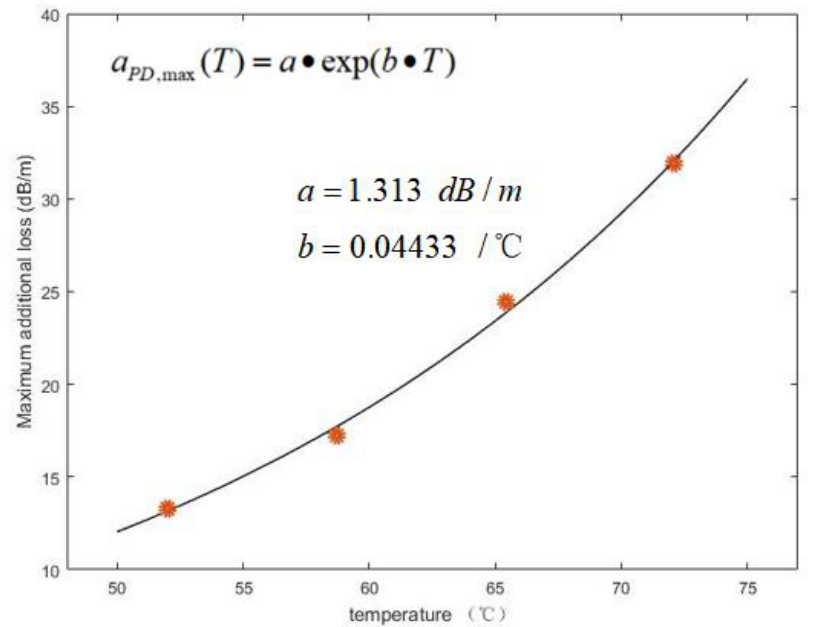
Figure 14. Relationship between core temperature and maximum additional loss. a and b in the figure is the fitting